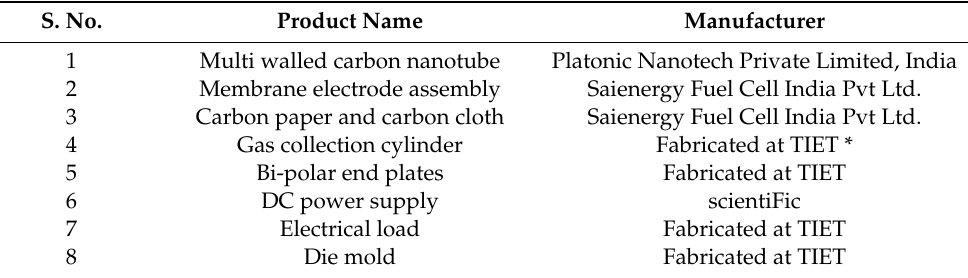
Table 1. List of materials used in this experiment.